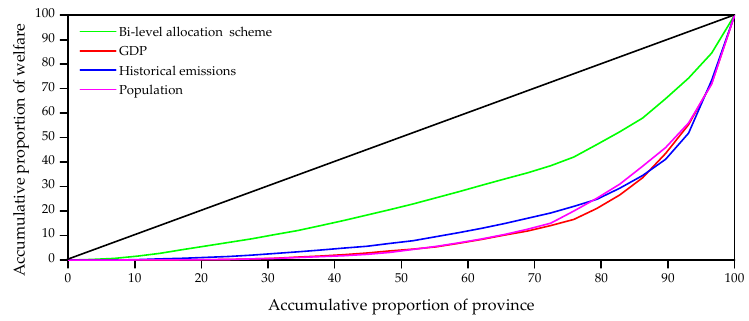
Figure 12. The Lorentz curve of welfare effect under target 2.